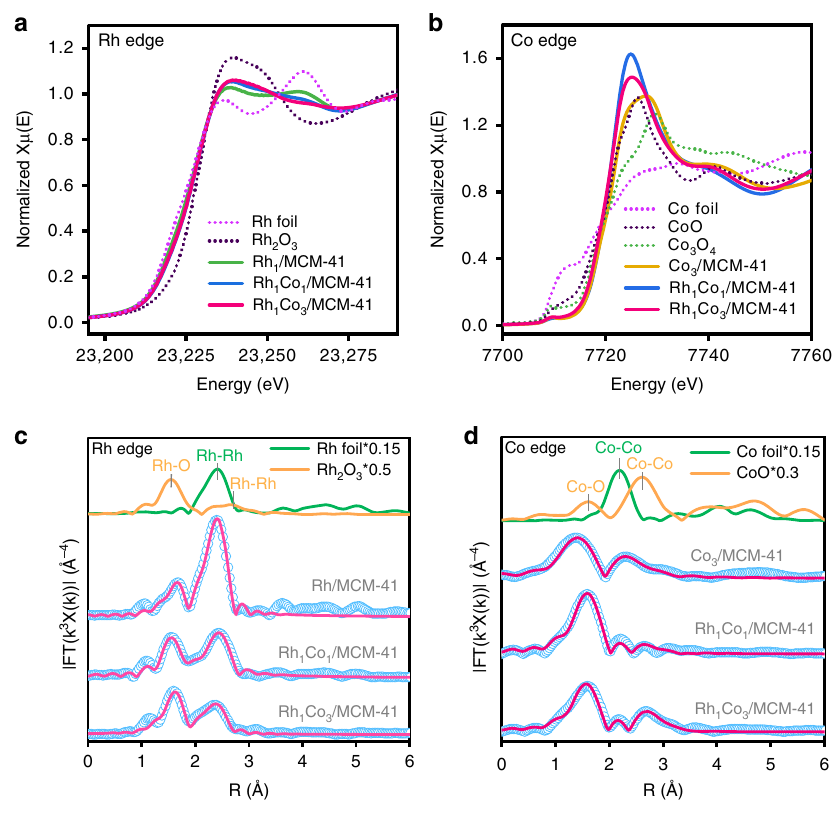
Fig. 4 Structural analyses of mono- and bimetallic MCM-supported Rh-based catalysts. a , b XANES spectra of Rh and Co K-edges. c , d Fourier transformed EXAFS spectra (sky blue circles) and fi ttings (deep pink line) of Rh and Co K-edges.